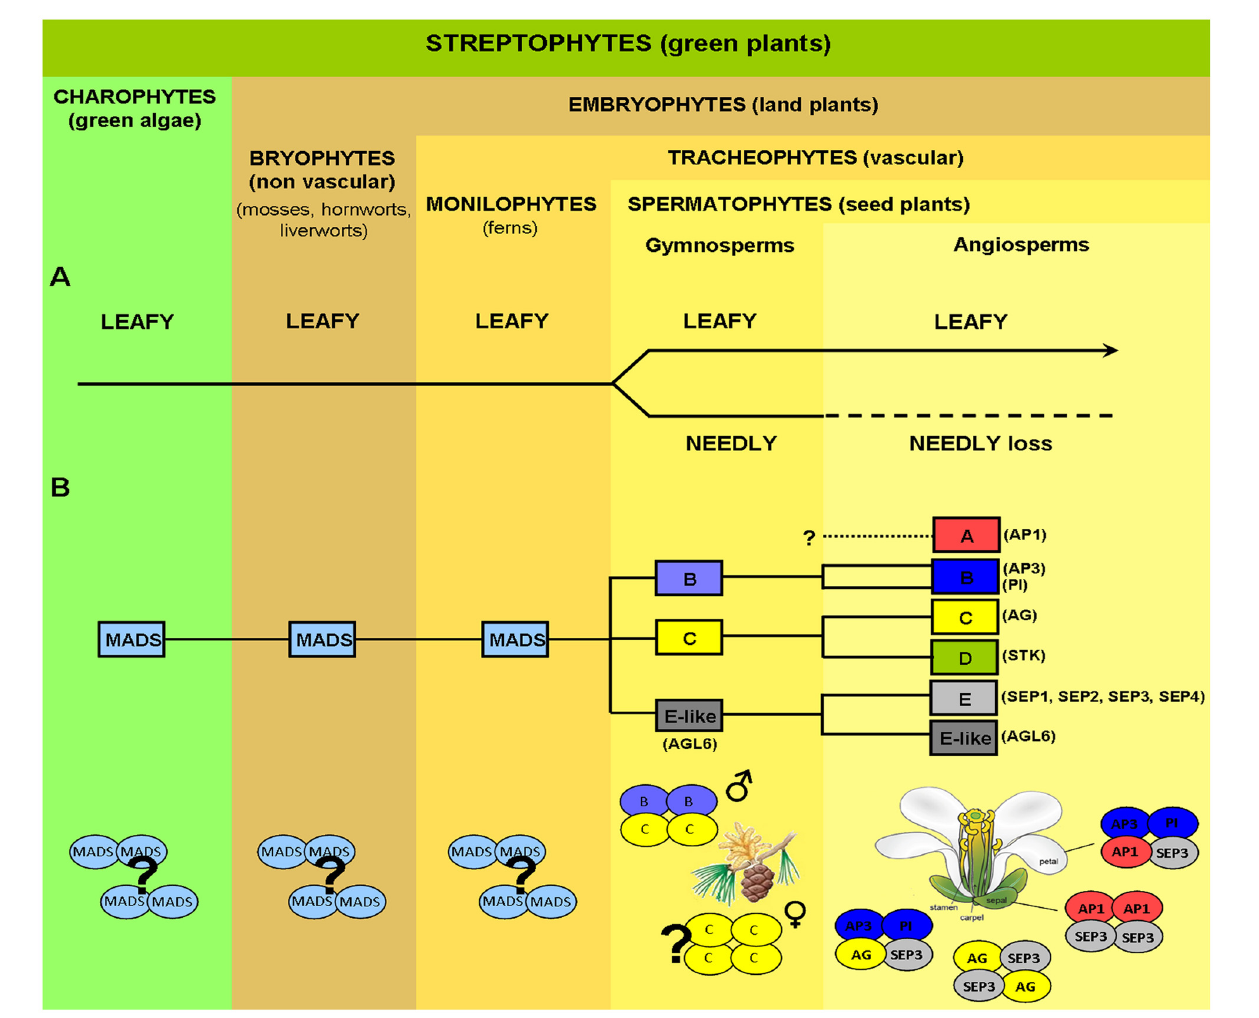
FIGURE 1 | Evolution of key genes controlling plant reproductive development. (A) Evolution of LEAFY ( LFY ) from green algae to angiosperms. LFY exists mostly as a single-copy gene in all streptophytes (green plants), with the exception of gymnosperms where a LFY -like paralog, NEEDLY ( NLY ), originated after a major duplication event (the only possible exception being the genus Gnetum ). In gymnosperms, LFY and NLY are consistently expressed in both male (pollen-bearing) and female (seed-bearing) cones, in a spatiotemporal coordinated manner. In the angiosperm lineage, NLY was subsequently lost, with LFY now regulating the expression of genes responsible for both the male and female organs in the unified bisexual flower. (B) MADS-box homeotic gene family. MADS-box genes are present in the most simple green algae and, as plants became more complex, the MADS-box gene family expanded via multiple duplication and specification events. Putative orthologs of class B, C, and E-like ( AGL6 ) floral homeotic genes have been isolated from different gymnosperms (conifers, gnetophytes, ginkgophytes, and cycads) as shown schematically by yellow and blue colored ovals. In contrast, SEP -like genes, the second subfamily conferring E-class function, as well as A-class genes, seem to be absent in extant gymnosperms but are present in all angiosperms. In gymnosperms, expression patterns of putative B and C-class gene orthologs resemble those of B and C-class genes in angiosperms, with B-class genes being expressed on male reproductive organs, whereas C-class genes are expressed in both male and female organs. In gymnosperms C-class proteins alone or C and B-class proteins together seem capable of forming tetrameric complexes (without any additional partners), which define, respectively, the female and male organs in these organisms as indicated. In angiosperms tetramer formation is dependent on the SEPALATTA (E-class) TFs which act as hubs by mediating interactions among proteins from different floral homeotic classes, strictly determining floral organ identity. Question marks indicate uncertainty as to physiological oligomerisation state, AP1, APETALA1; AP3, APETALA3; PI, PISTILLATA; AG, AGAMOUS; STK, SEEDSTICK; SEP, SEPALLATA; AGL6, AGAMOUS LIKE 6.